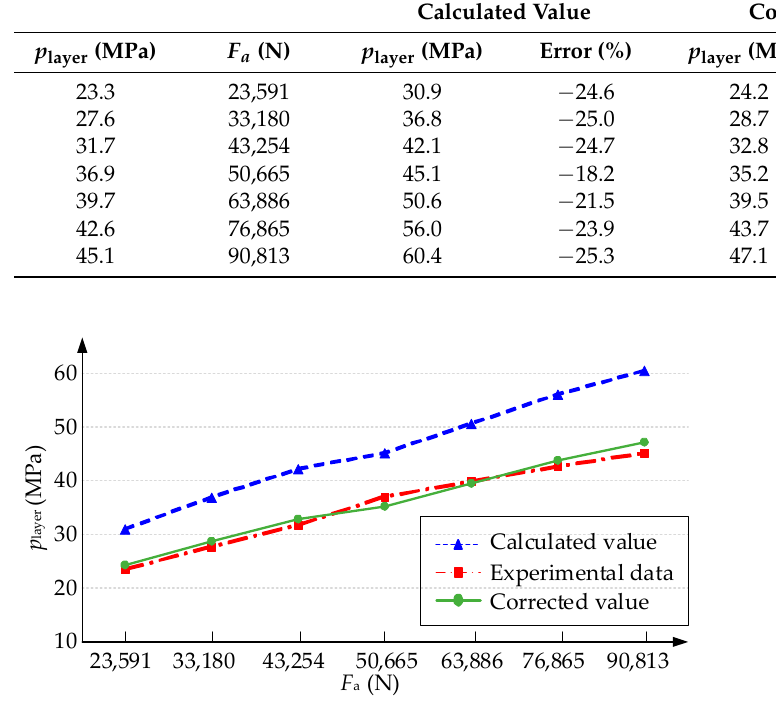
Figure 13. Errors in interlayer pressure test data.